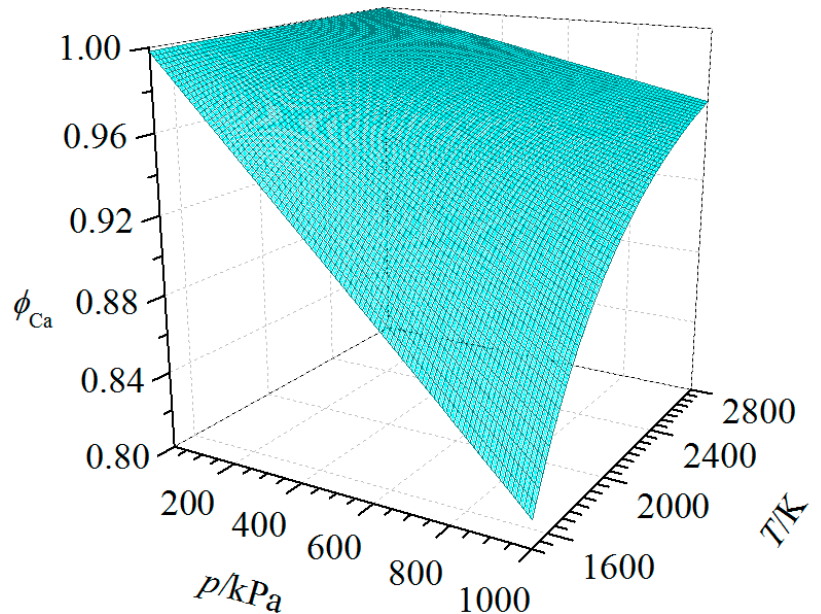
Figure 3. Fugacity coefficient of Ca.